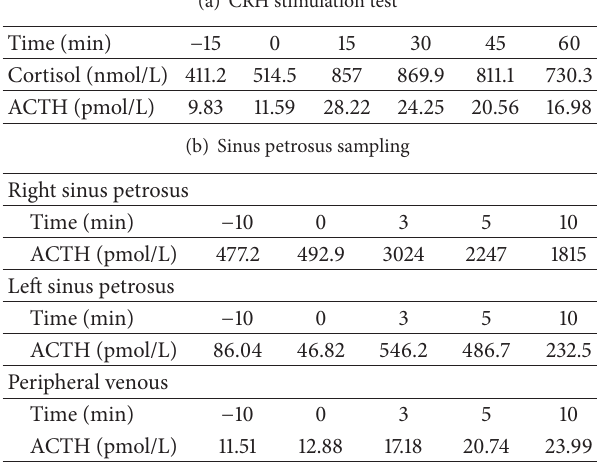
Table 2: CRH stimulation test and petrosal sinus sampling con- firmed the diagnosis of an ACTH-dependent